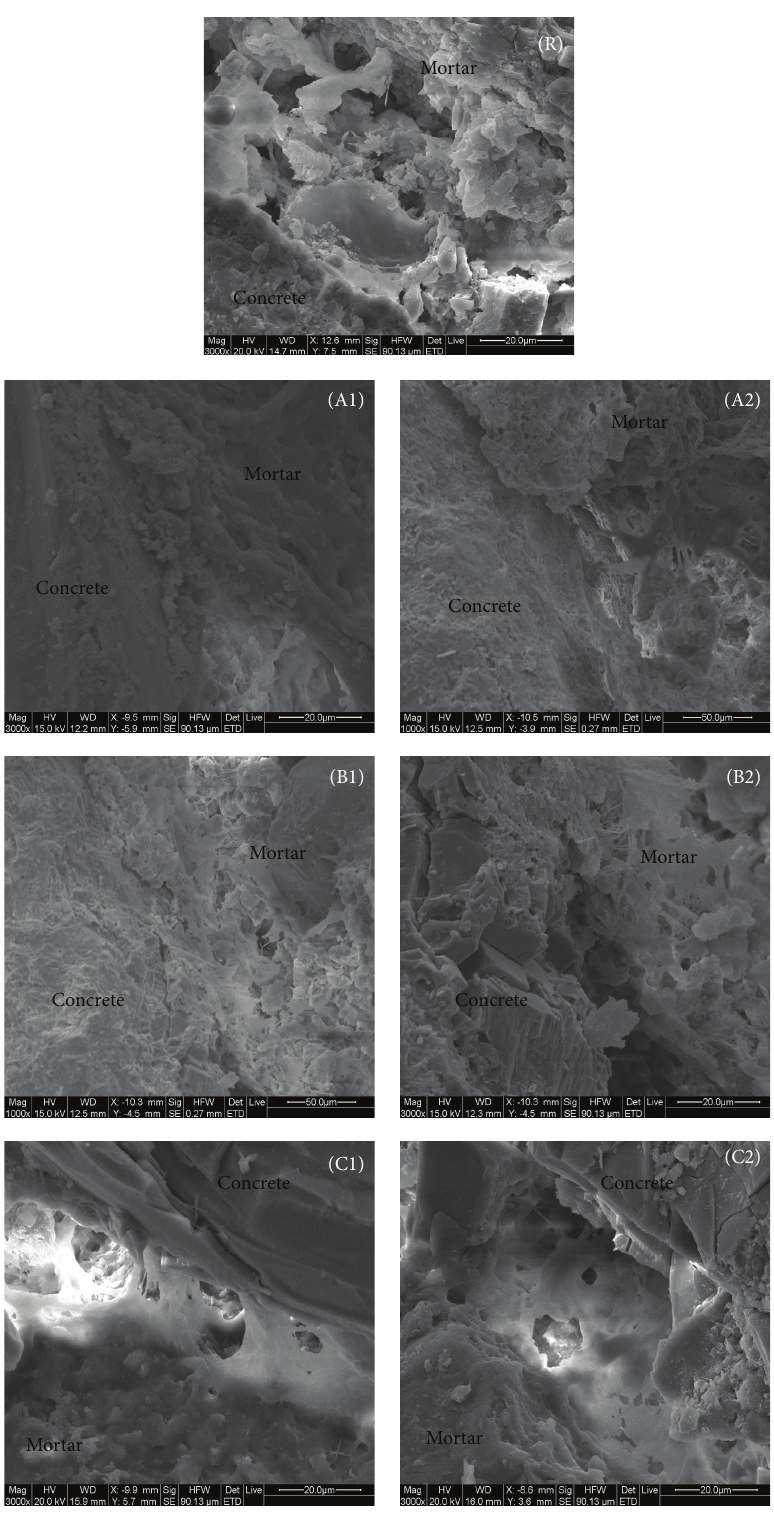
Figure8:Microstructureofinterfacebetweenrepairmortarsandoldconcreteobservedbyscanningelectronmicroscope(SEM).(R)Interface of ordinary repair mortar and concrete; (A1) SBR formed film at the surface; (A2) SBR formed filament at the interface; (B1) SAE dispersion formed film at the interface; (B2) SAE dispersion formed mesh-like products at the interface; (C1), (C2) SAE powder formed film at the